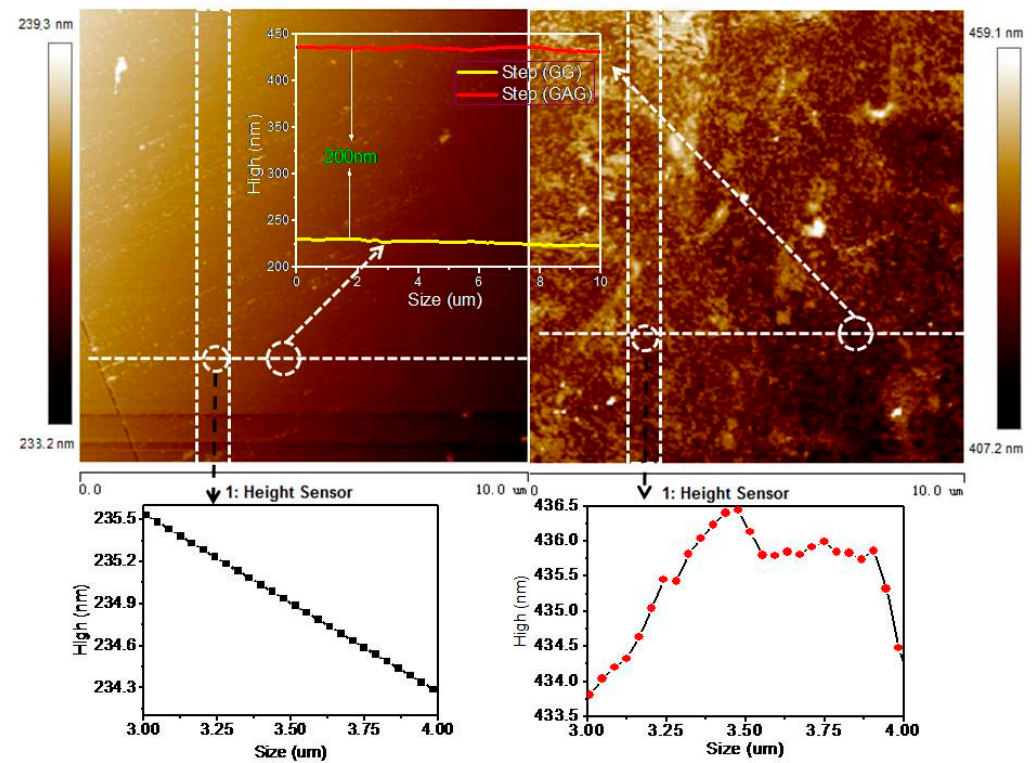
Figure 8. Atomic force microscope (AFM) image of GAG transparent conductive layer and the AFM of graphene-graphene.